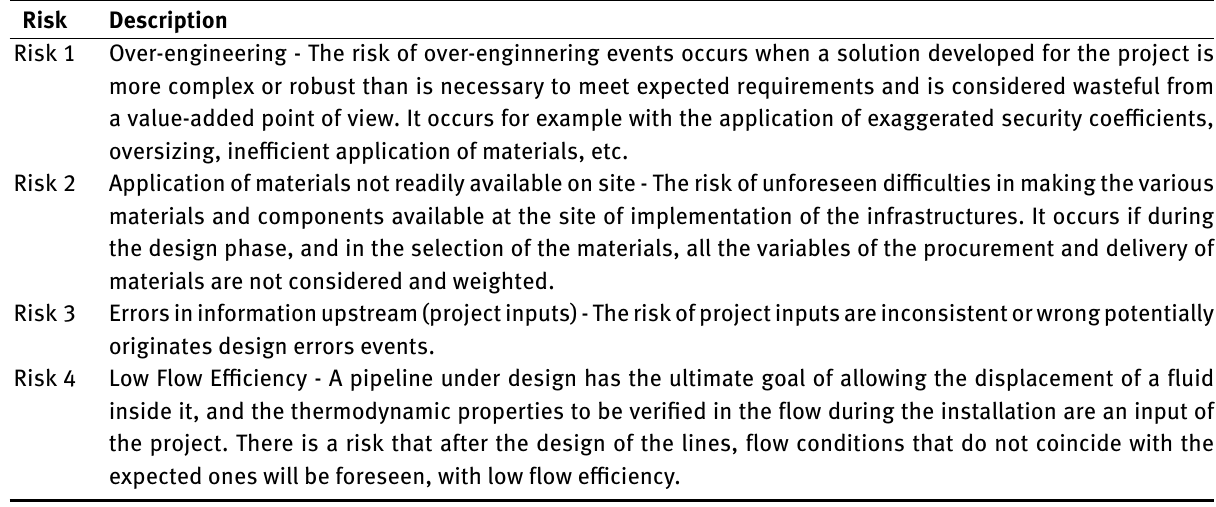
Table 5: Identified Risks in Piping Design.